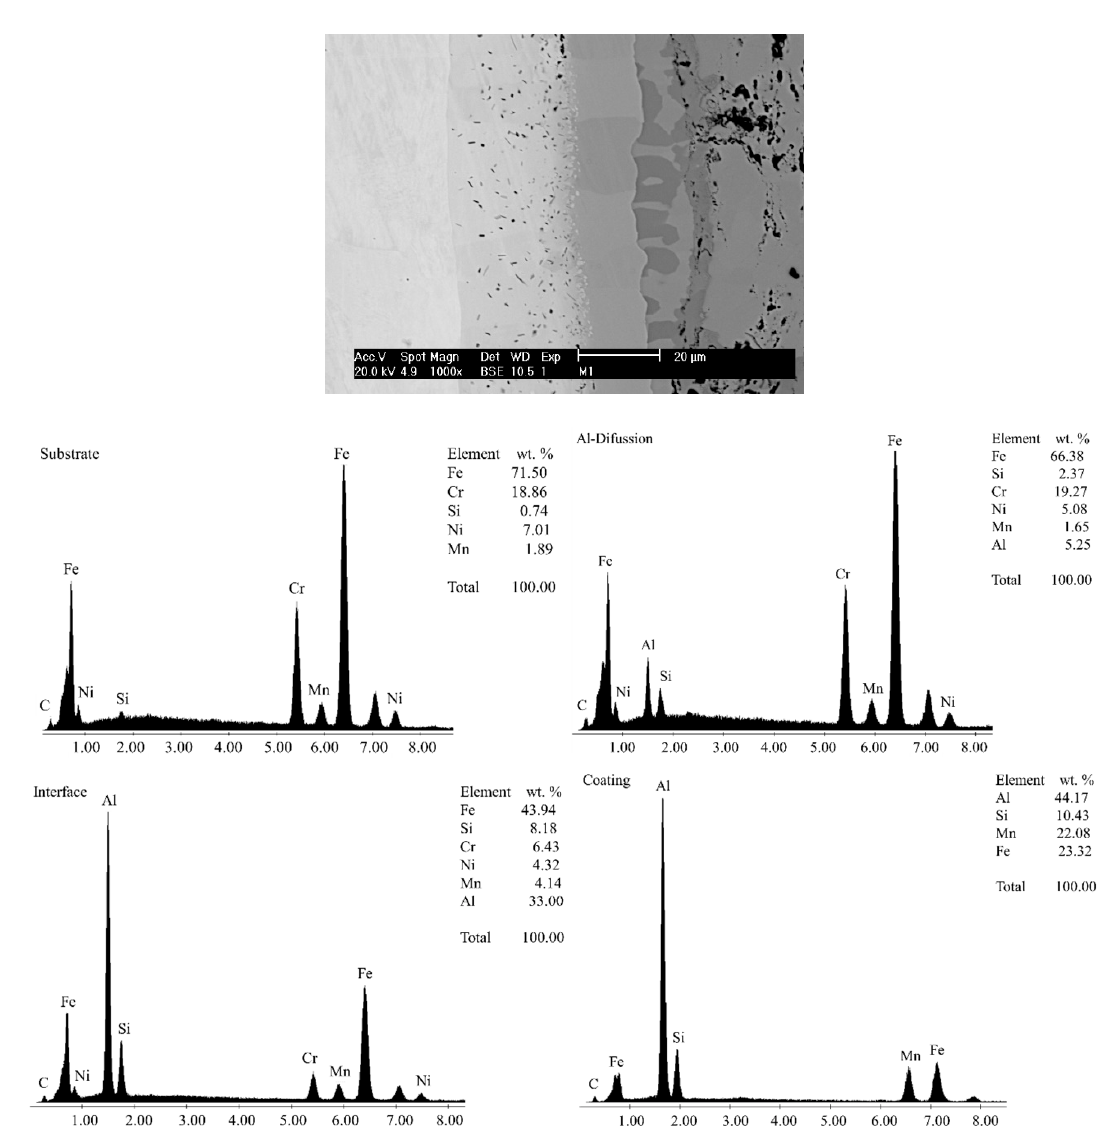
Figure 5. SEM image of the cross section of a sample processed at 850 ◦ C and 20 MPa for 7200 s, and the corresponding Energy dispersive spectroscopy (EDS) spectra of the layers of reaction indicated in the micrograph.